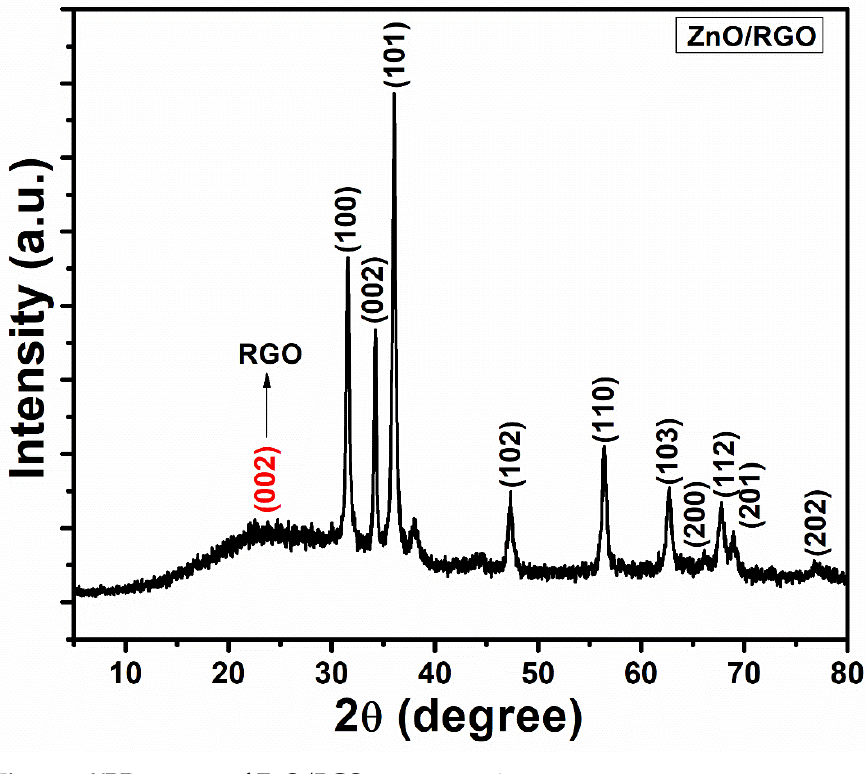
Figure 2. XRD patterns of ZnO/RGO nanocomposites.